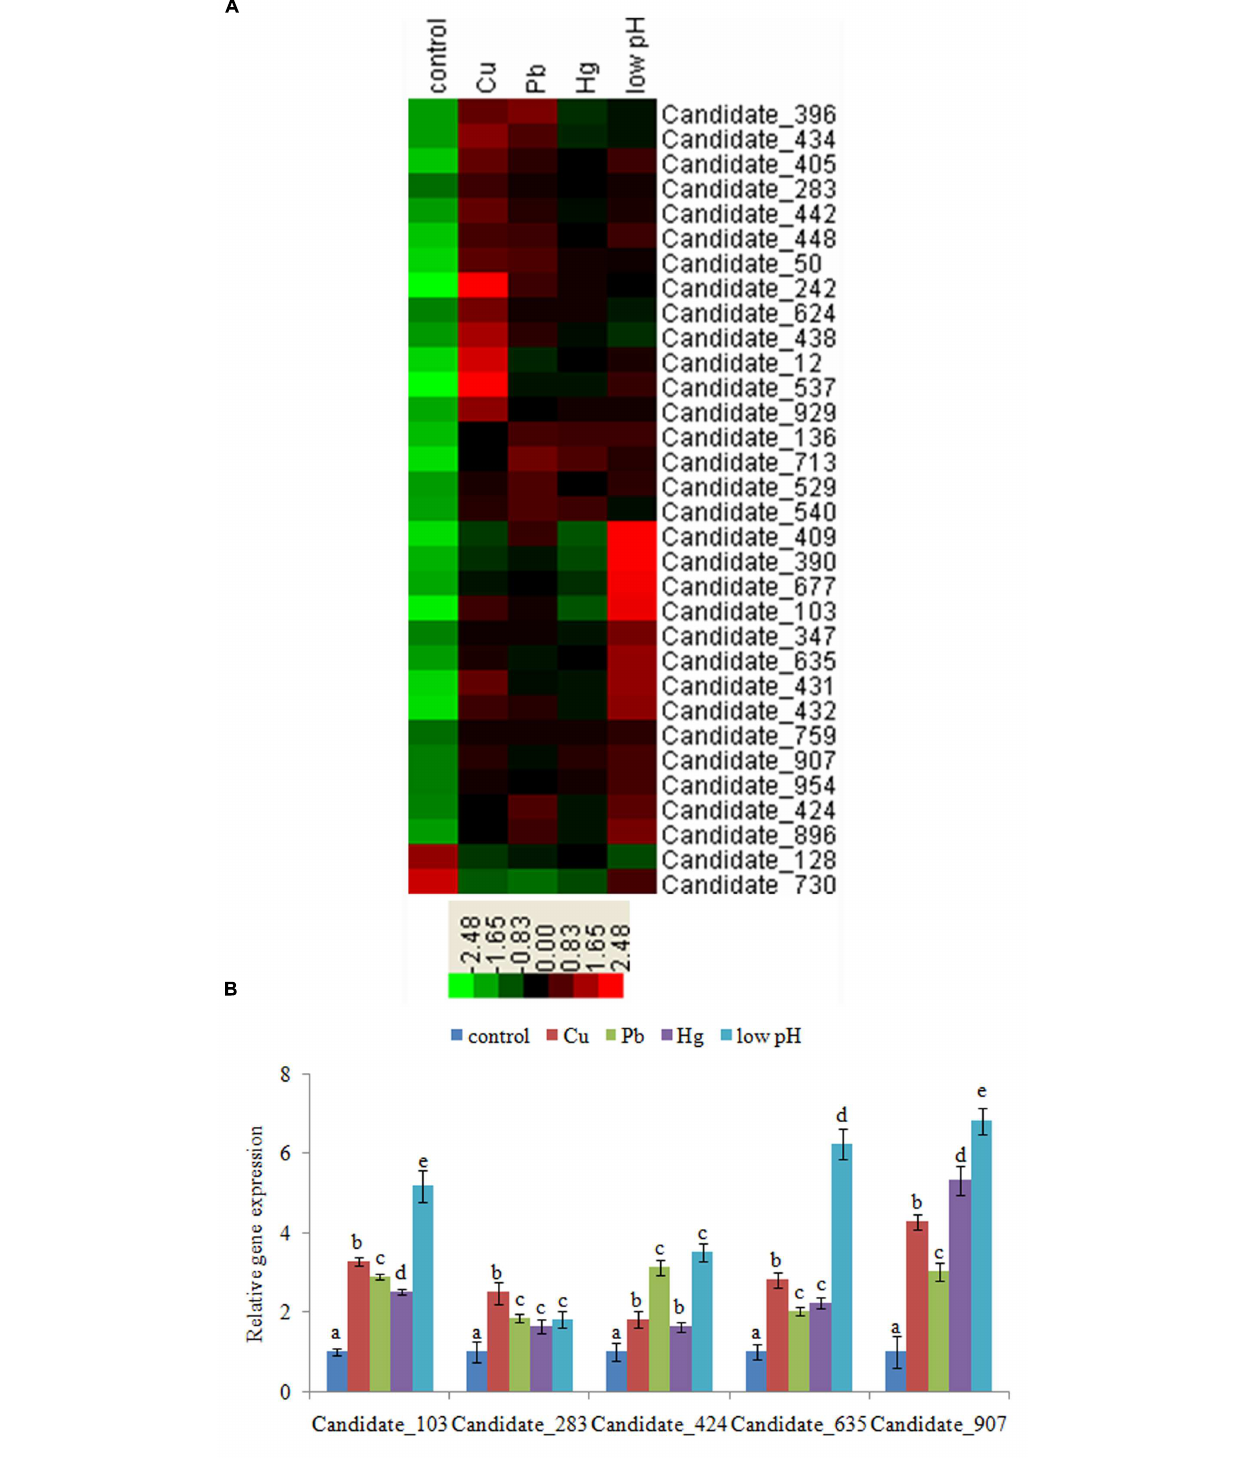
Frontiers in Microbiology |